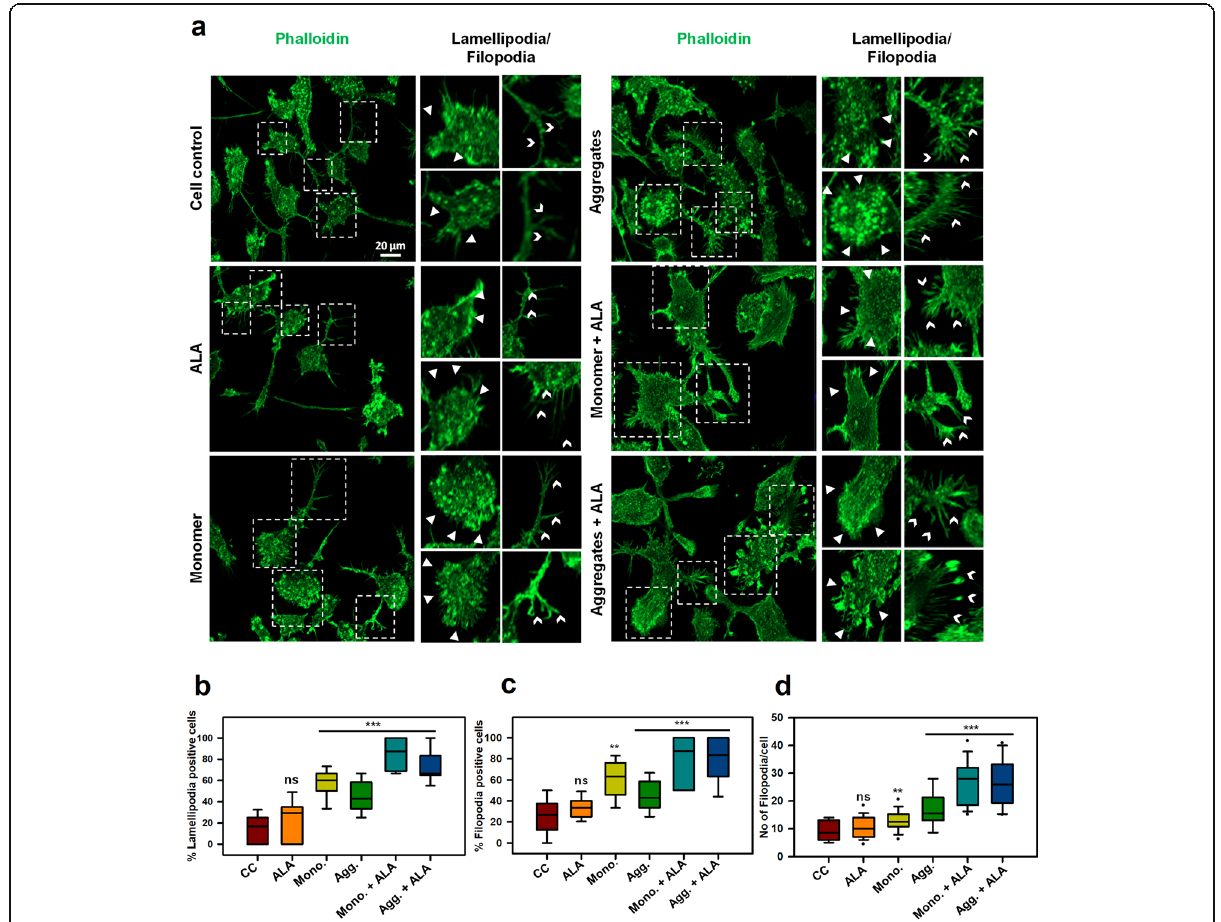
Fig. 5 Enhancement of actin-rich structures for migration in microglia. Actin plays a significant role in the migration of microglia by providing mechanical strength as well as direction support. a Actin based structures lamellipodia, filopodia were observed after 24 h exposure Tau monomer, aggregates along with ALA to microglia cells by fluorescence microscopy. The enlarge panel indicates the presence of lamellipodia (white triangles), filopodia (white arrow heads) from the fluorescence image. The enlarged regions are denoted with the white dotted square in the image, scale bar is 20 μ m. b The graph represents quantification of percentage of lamellipodia positive cells per 10 fields of different treatment groups, ( p < 0.001) as compared to cell control (untreated) and ALA. c The graphical representation of percentage of filopodia positive cells per 10 fields of different treatment groups Tau monomer, aggregates along with ALA showed high significance of ( p < 0.001) d Quantification of number of filopodia extensions present per cell per 10 fields of different groups, significance is ( p < 0.001). The significance was analyzed with Tukey ’ s Kramer, significant when mean difference between treatment groups (X-X ’ ) > T (Tukey ’ s criteria). The annotations used in graph are as follows- CC (Cell control), ALA ( α -linolenic acid), Mono. (monomer), Agg. (aggregates), Mono. + ALA (monomer plus ALA), Agg.